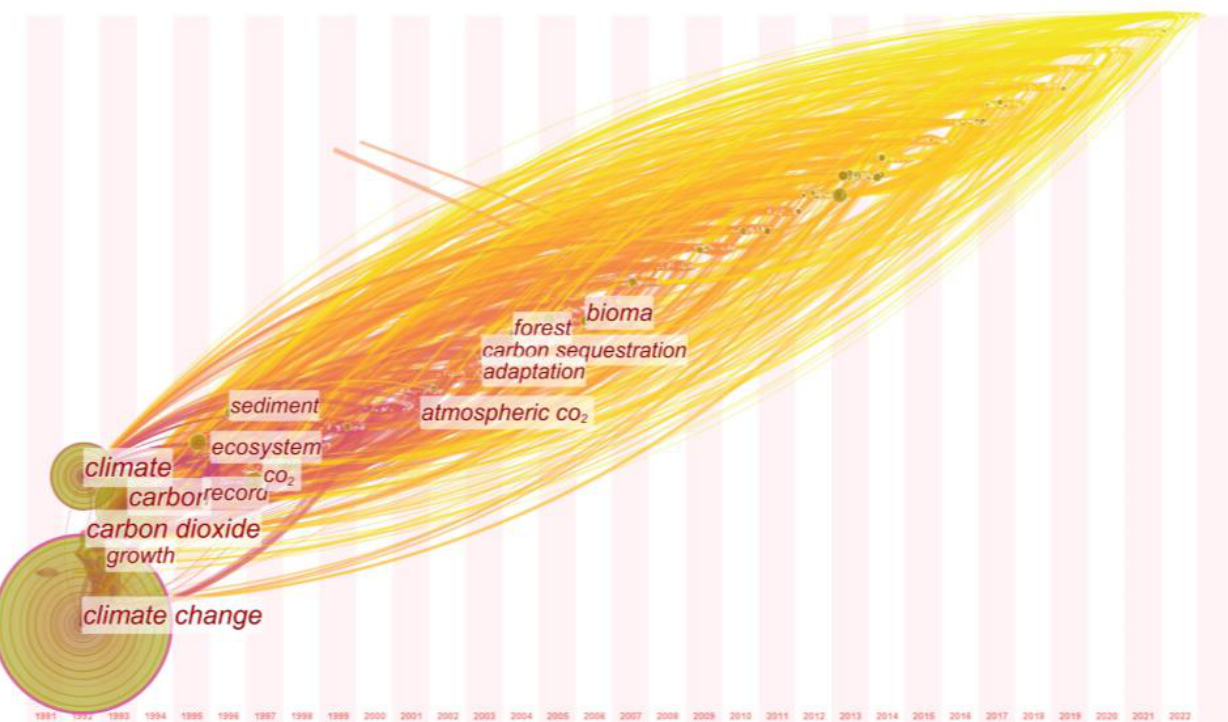
Figure 5. National time zonal mapping for RCHSCC.